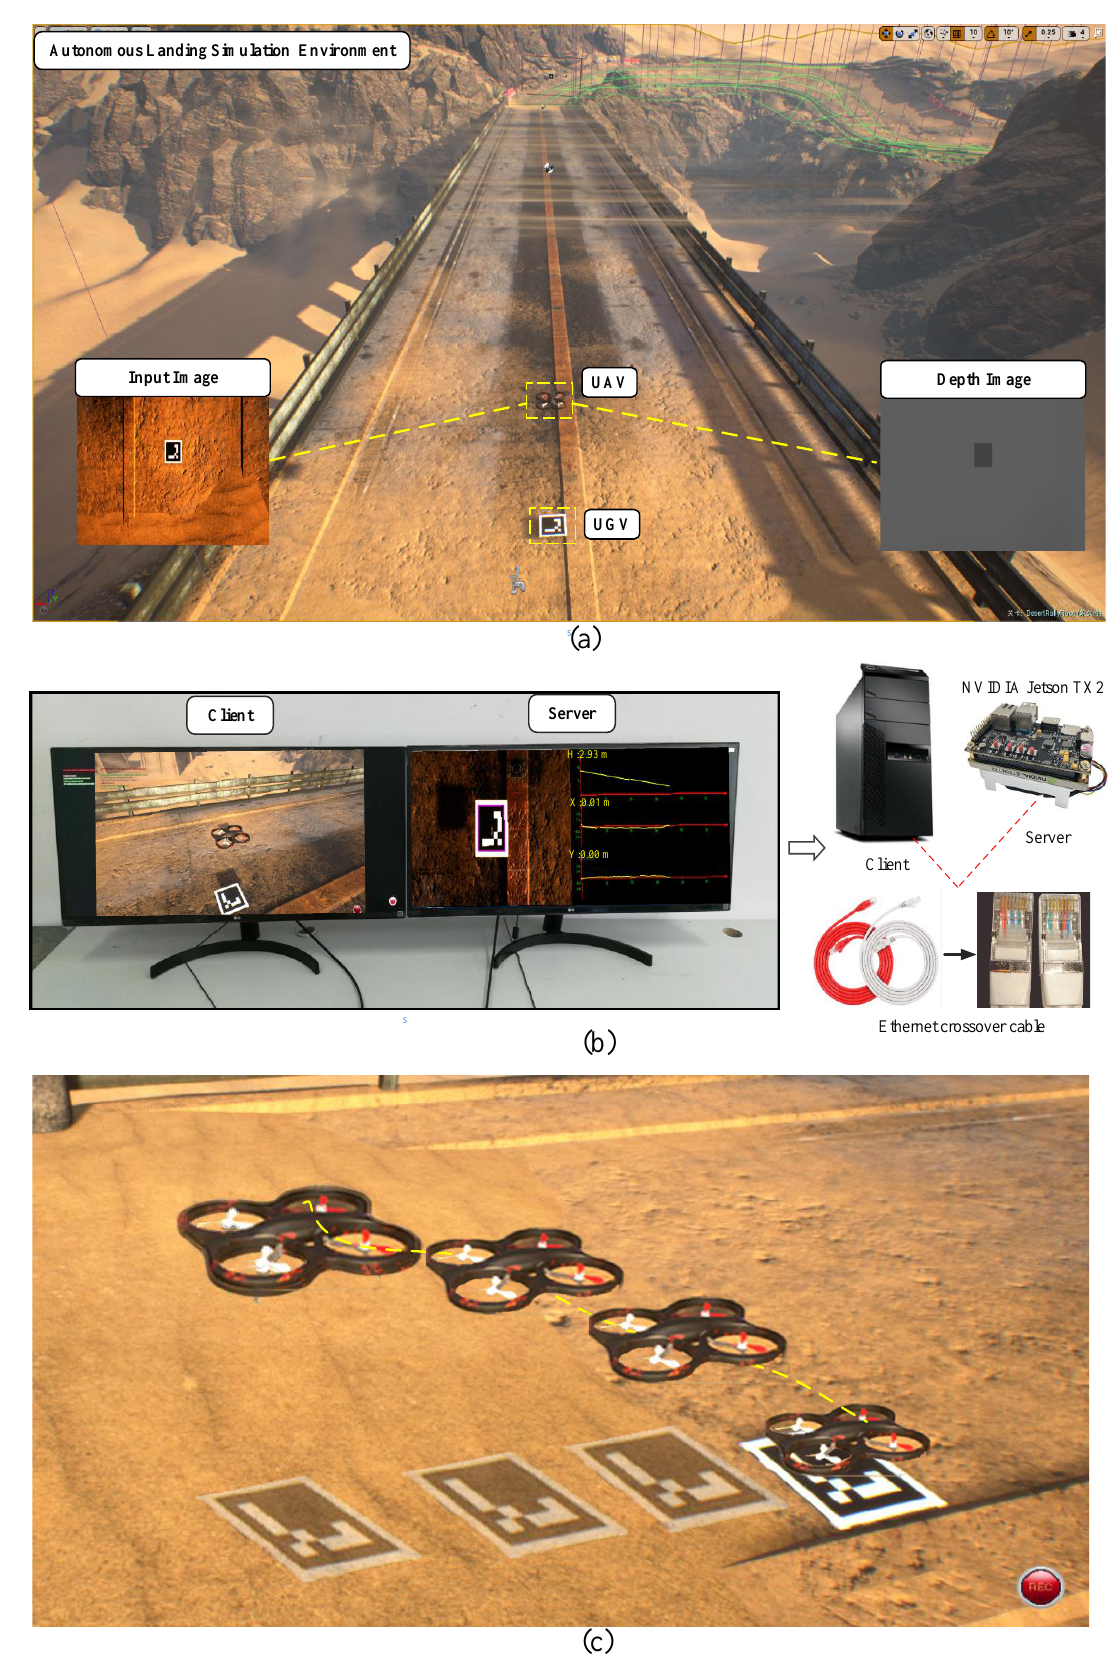
Figure 7. Our simulation environment based on Microsoft AirSim. ( a ) A screenshot of our test environment; ( b ) The running simulation environment and the requiring physical equipment; ( c ) A schematic diagram of the autonomous landing of the UAV in our simulation